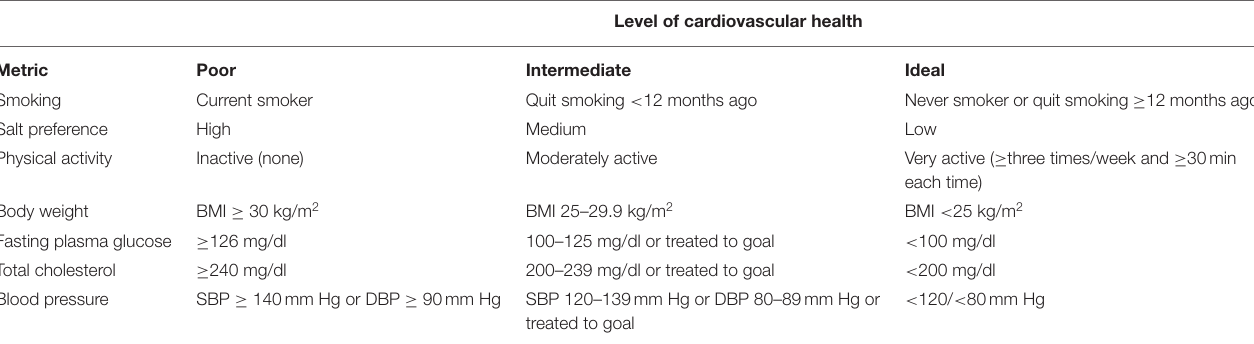
TABLE 2 | Definitions of cardiovascular and cerebrovascular health metrics from the KaiLuan